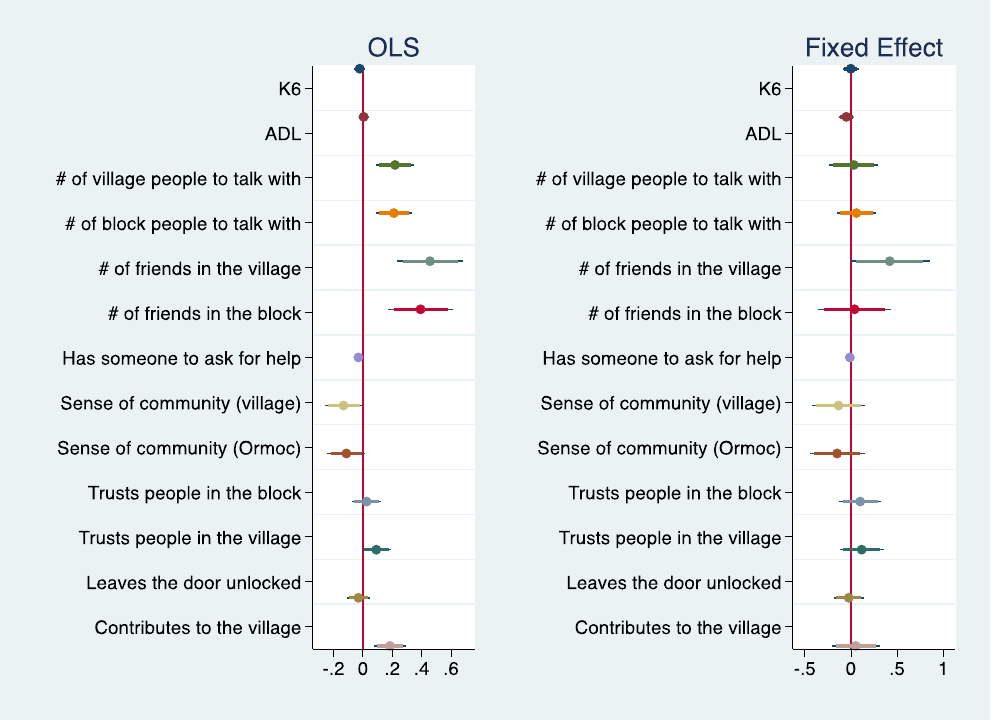
Figure 2. The impact of Ibasho participation on selected outcomes (Philippines). Note : The graph summarizes the coefficient on Ibasho participation for each outcome after controlling for age, gender, years of living in the community, marital status, working status, academic degree, monthly household expenditure, family type, and housing situation as well as round